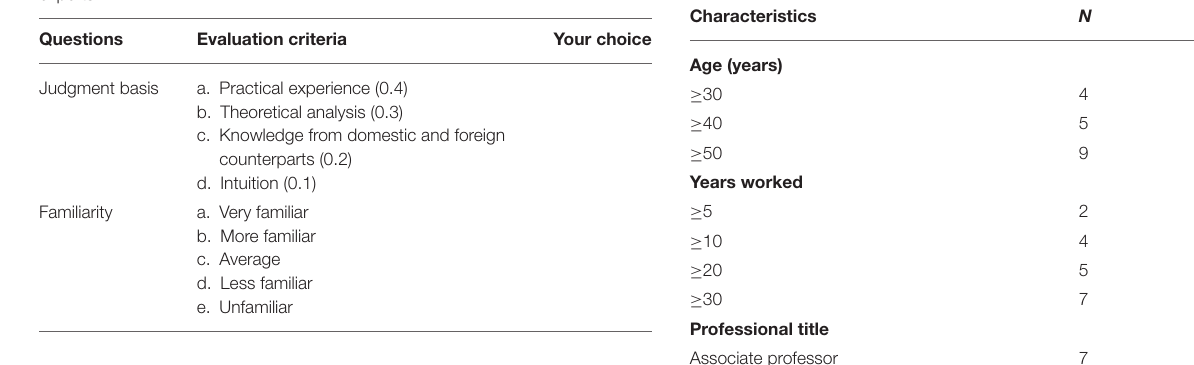
TABLE 2 | Judgment basis and familiarity with the topics for consultation from experts.